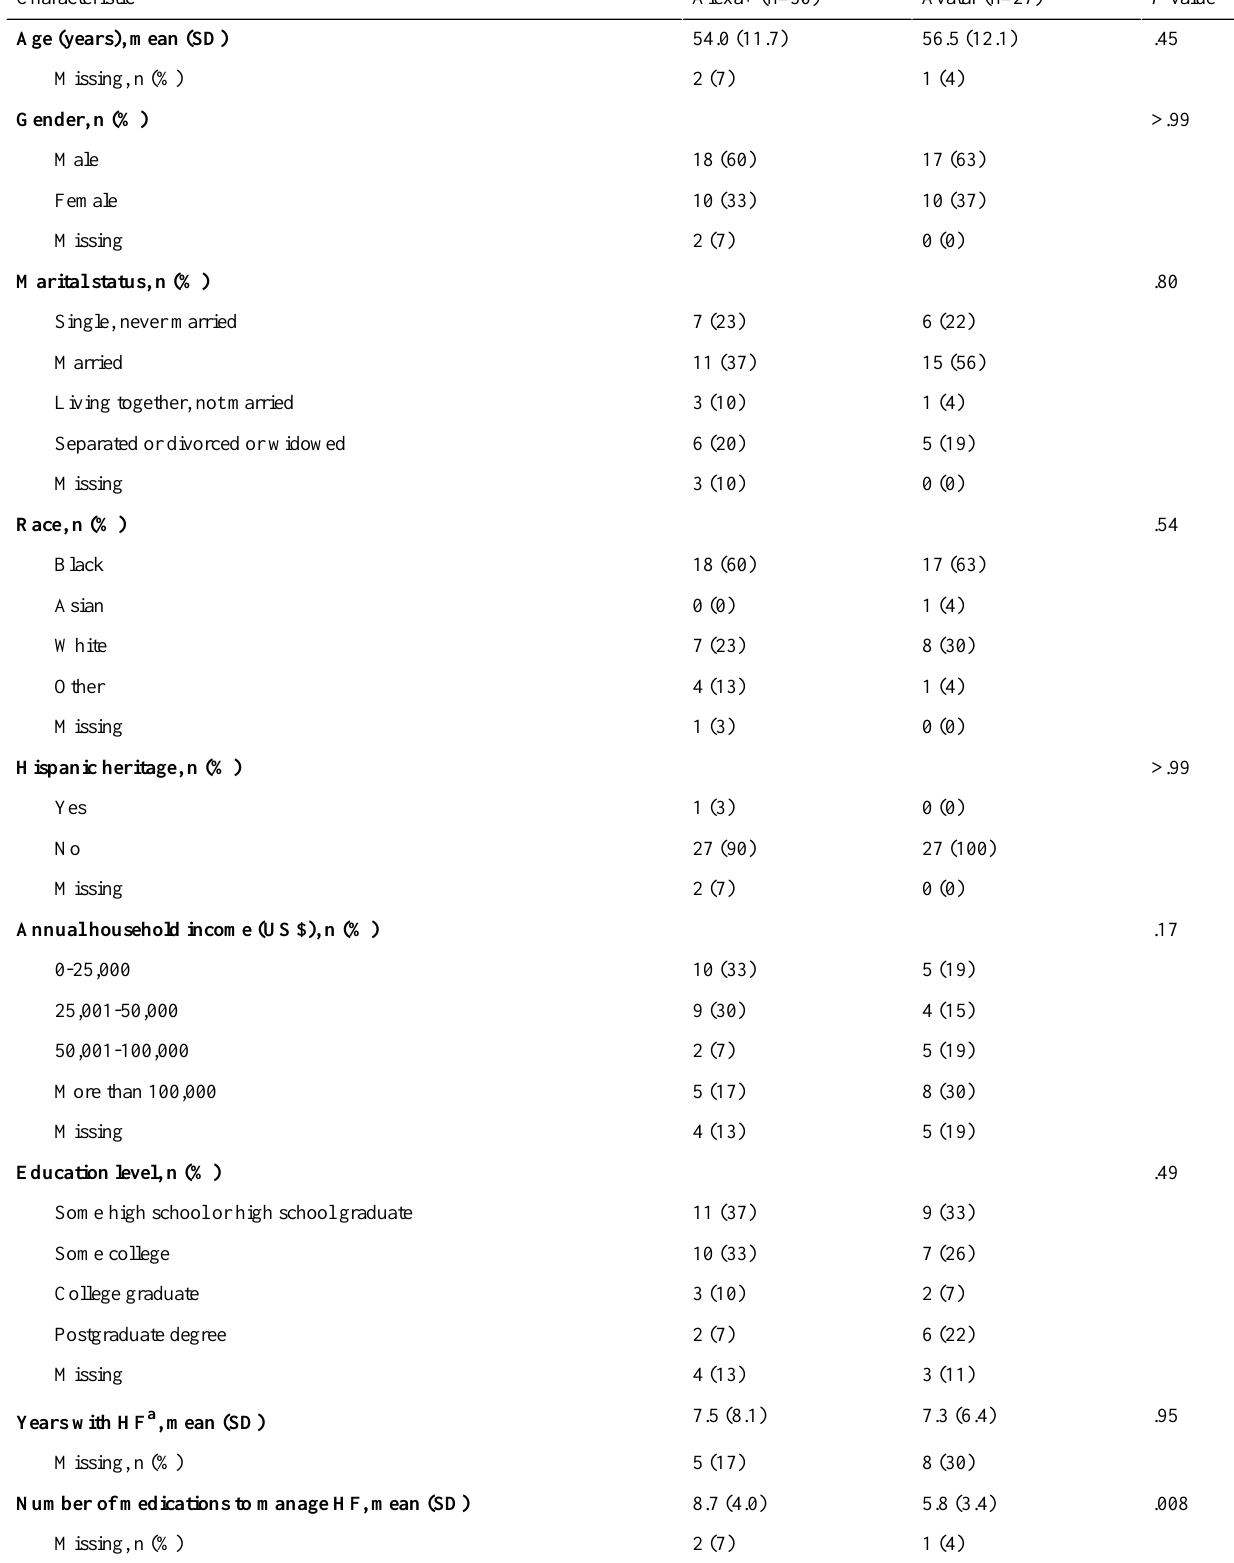
P valueAvatar (n=27)Alexa+